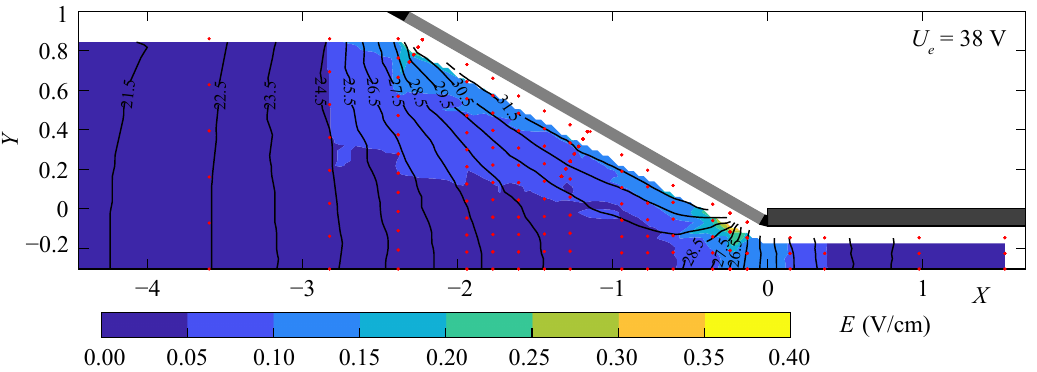
Figure 4. Contour map of the electric field strength E (V/cm) measured 11 cm above the flume bottom with an applied voltage at the rack of U e = 38 V; measurement locations are indicated with red dots and the equipotential lines (constant voltage) are shown in increments of 1